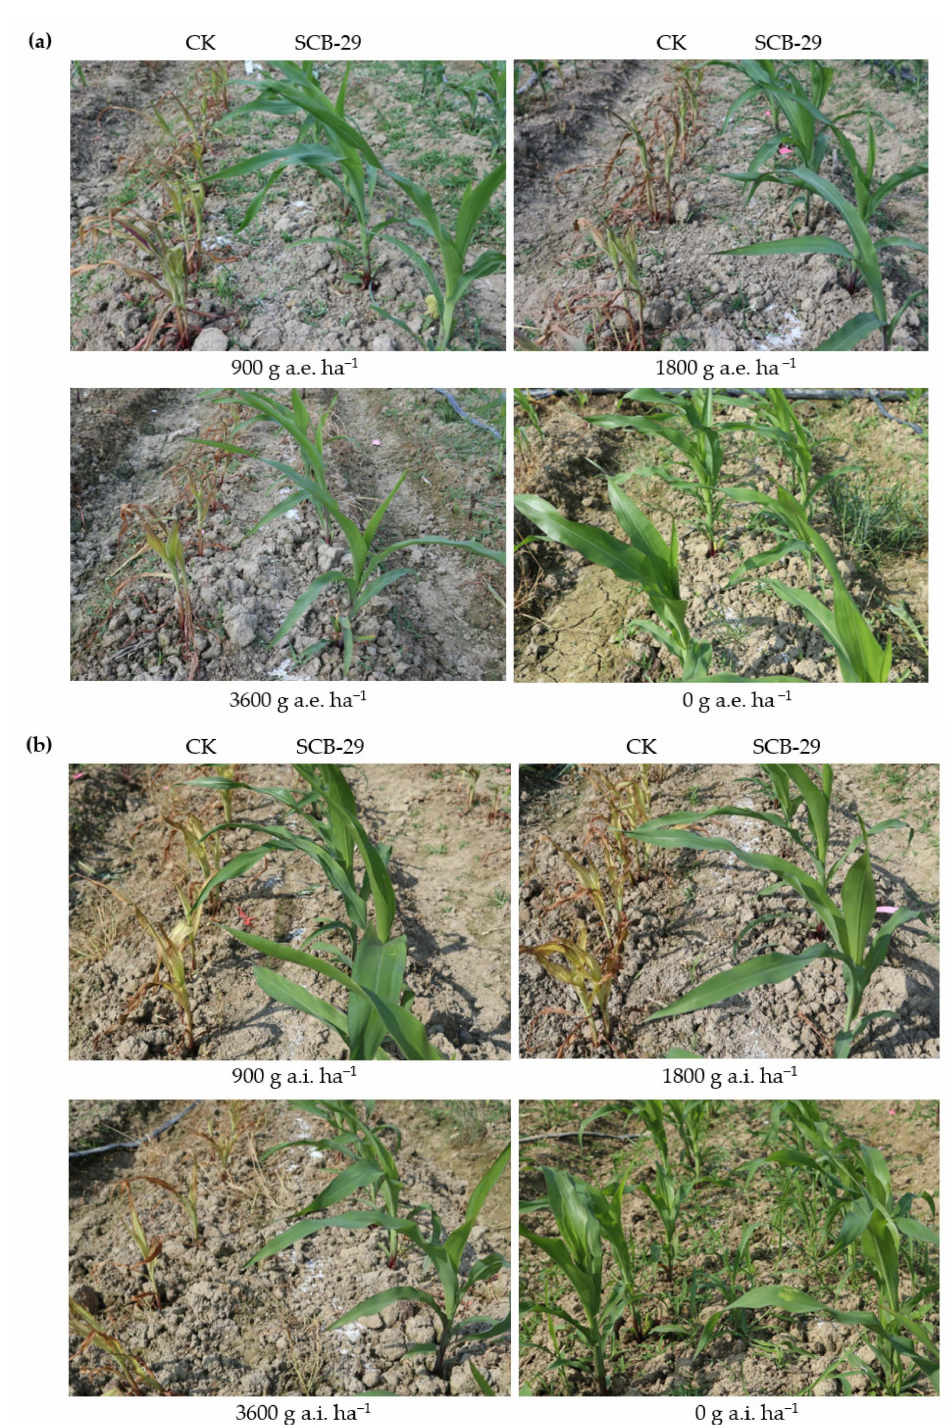
Figure 7. Herbicide tolerance analysis of transgenic maize SCB-29. ( a ) Spraying glyphosate